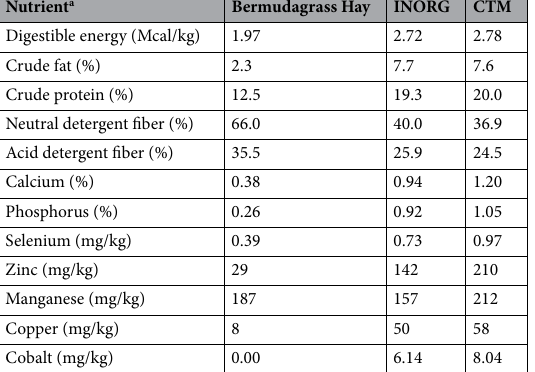
Table 4. Nutrient composition of bermudagrass hay, inorganic (INORG) concentrate and complexed trace mineral (CTM) concentrate. a Values presented on a 100% DM